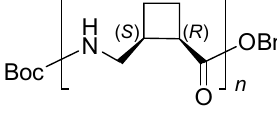
Figure 21. Top : Schematic representation of head-to-head arrangement of a dimer of conjugate 30 . π – π and H-bonding interactions are highlighted in red. Bottom : Top and side view for the pre- dicted structure of a dodecameric aggregate of 31 . Non-polar H atoms were omitted for clarity. Adapted with permission of Elsevier [52].